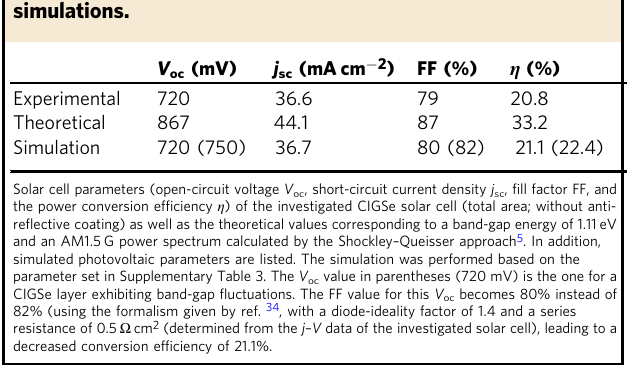
82% (using the formalism given by ref. 34 , with a diode-ideality factor of 1.4 and a series resistance of 0.5 Ω cm 2 (determined from the j – V data of the investigated solar cell), leading to a decreased conversion ef fi ciency of 21.1%.